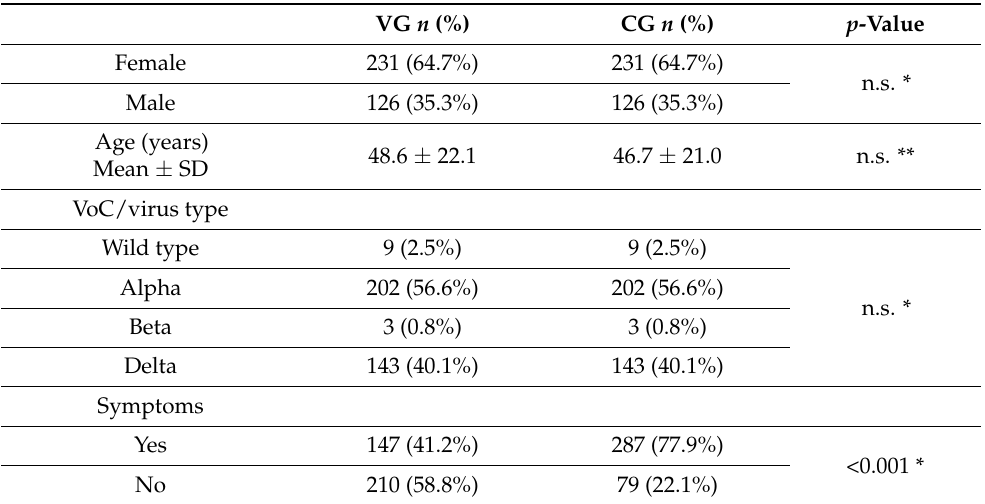
Table 1. Demographic characteristics, and differences between VG (vaccinated group) and CG (control group). * χ 2 -test; ** unpaired t